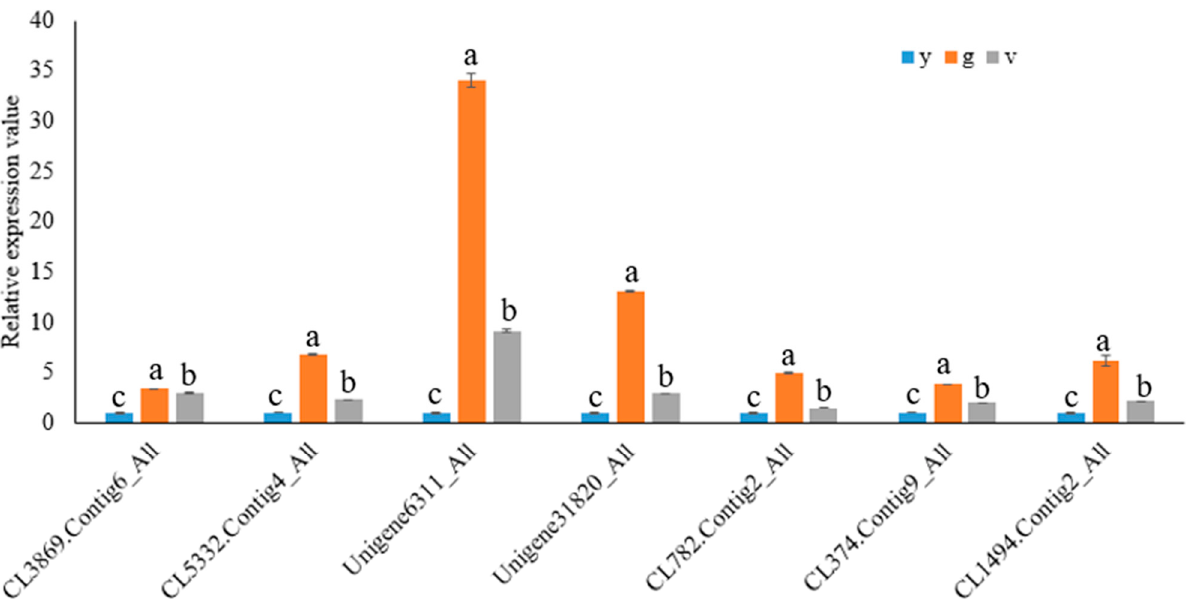
Figure 10. Quantitative real-time PCR verification of RNA-Seq data. Seven DEGs were selected for the verification of the reliability of the transcriptome sequencing results. The expression of β -actin was used as an internal reference. Data represent means ± SEM of three independent experiments. Different lowercase letters (a, b and c) indicated a significant difference among yellow leaves (y), green sectors of the variegated leaves (g) and yellow sectors of the variegated leaves (v) at p < 0.05 level. a: significant difference compared to yellow sectors of variegated leaves; b: significant difference compared to green sectors of variegated leaves; c: significant difference compared to juvenile yellow